Question: What visual encoding does this figure use to show its data?
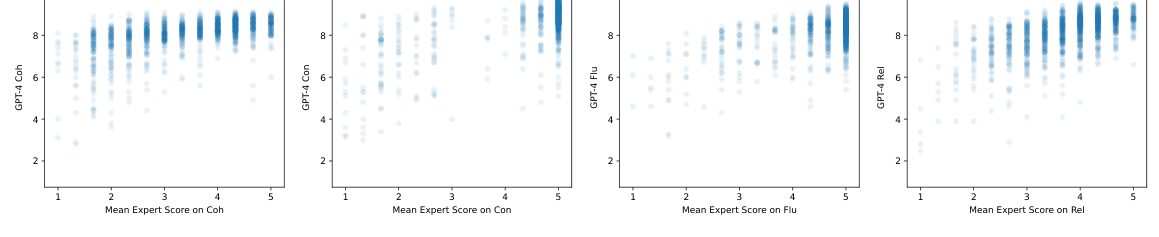
Answer: scatter